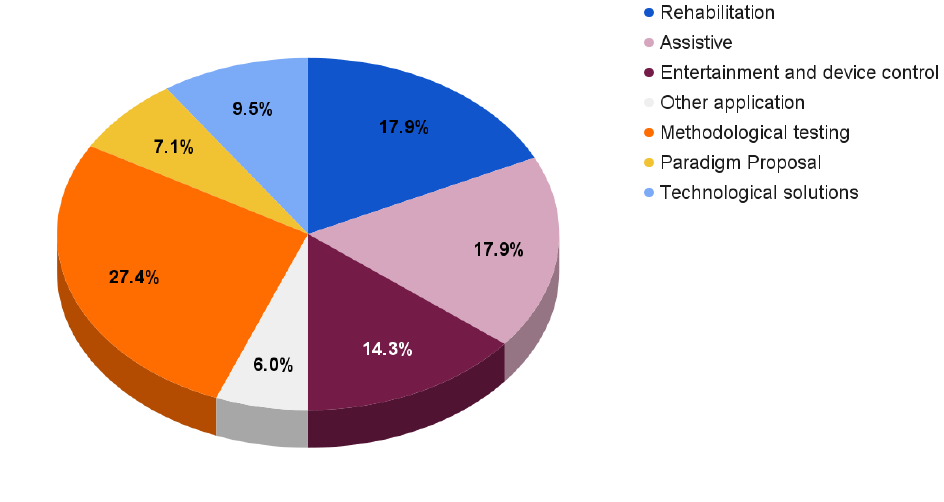
Figure 6. Reviewed paper distribution according to different fields of applications and